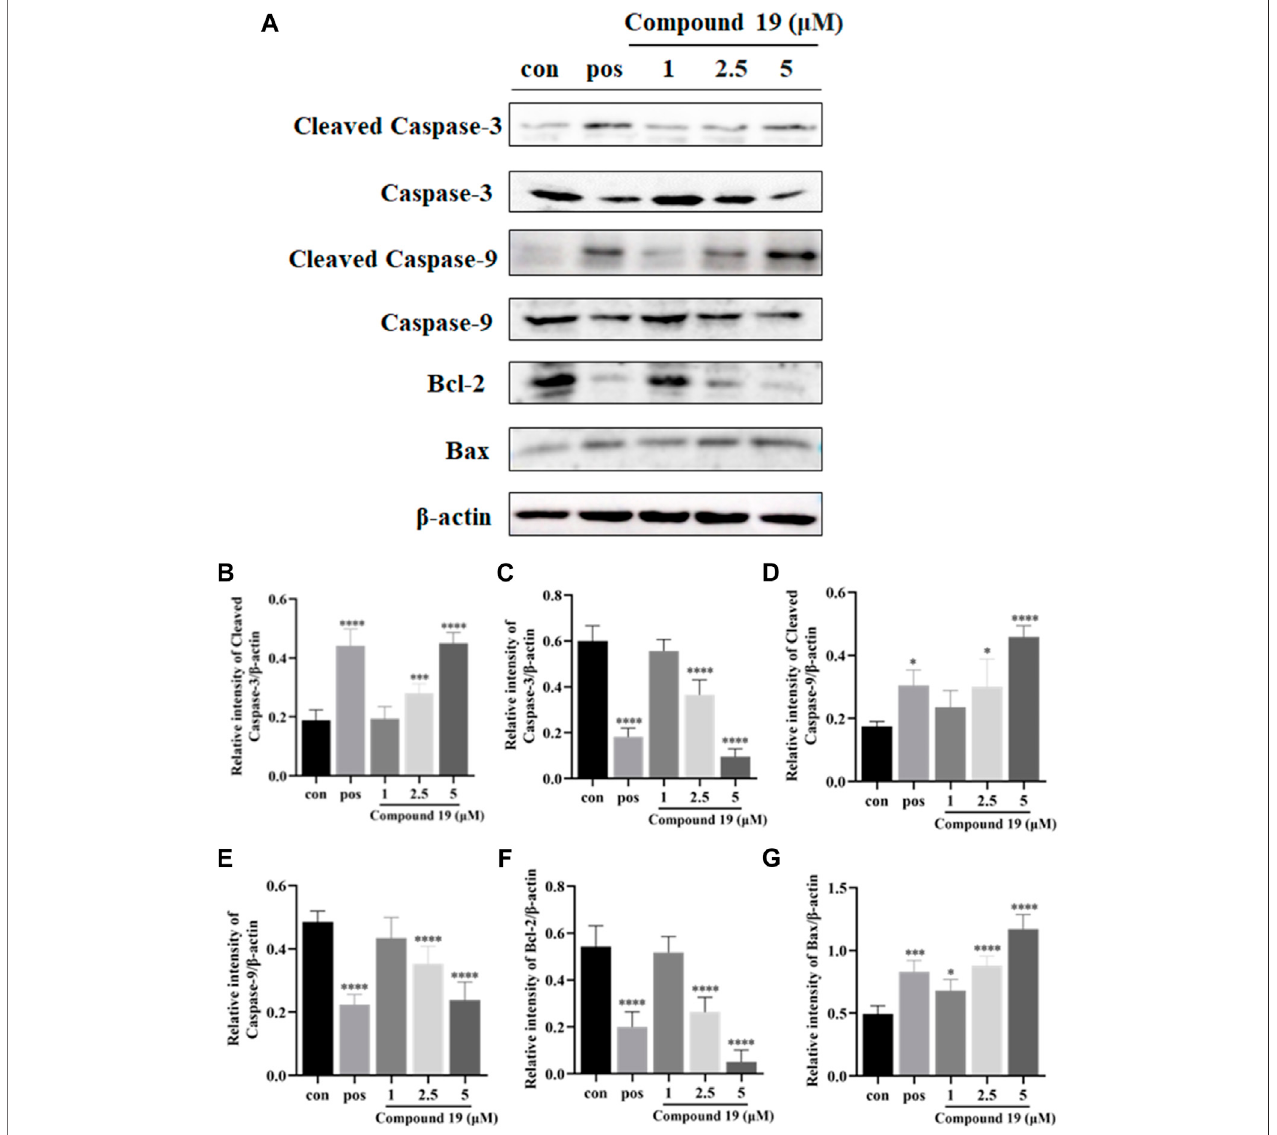
FIGURE6| Impactof compound 19 on the protein expressions ofcleaved caspase-3, cleaved caspase-9, caspase-3, caspase-9, Bcl-2, and BaxinHepG2 cells. Cellswereseededin6-wellplates(1×10 6 cells/well)andtreatedwithdifferentconcentrationsofcompound 19 (1,2.5,and5 μ M)for48 h.Westernblottingwasusedto detect the protein expression levels after compound 19 was applied to HepG2 cells (A) . The ratio of the corresponding protein to β -actin is calculated in (B – G) . The experiments were run in triplicate. Data were presented as mean ± SD. p p < 0.05, pp p < 0.01, and ppp p < 0.001 vs . the control group.